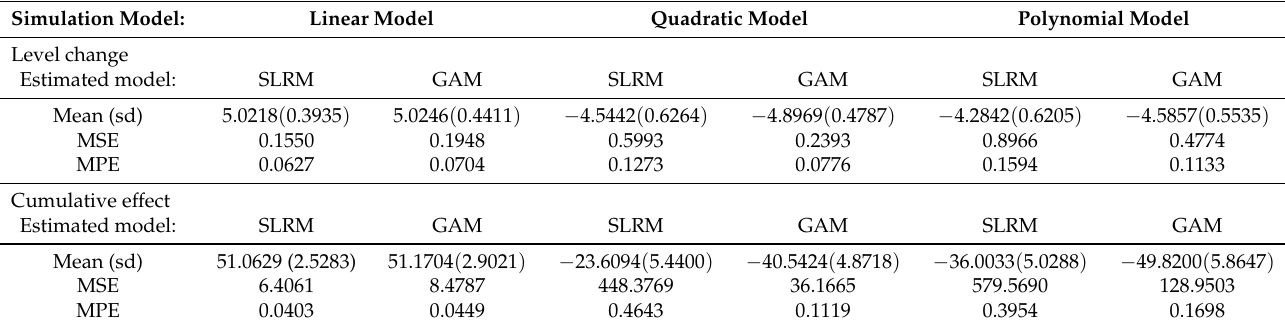
Table 2. Results of the simulation